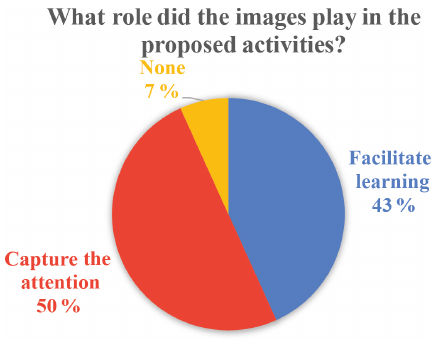
Figure 14. The pie chart illustrates which role the images played for the